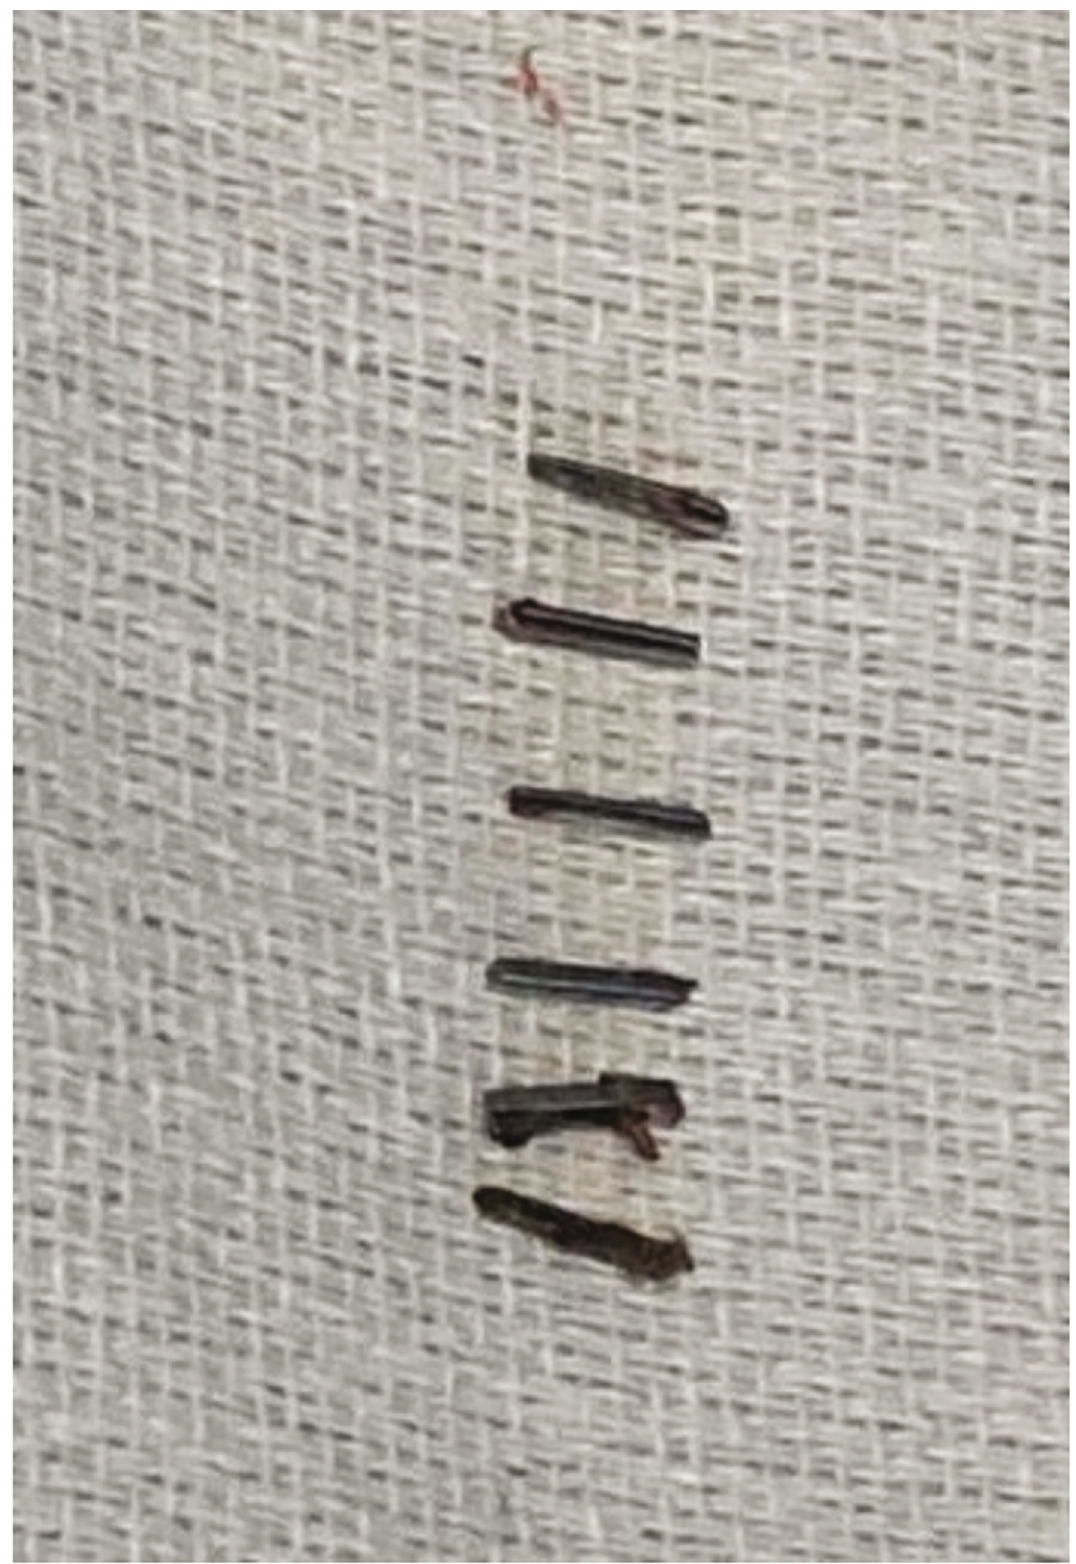
Figure 1: Six metal surgical clips removed from the RUQ via fl uoroscopic